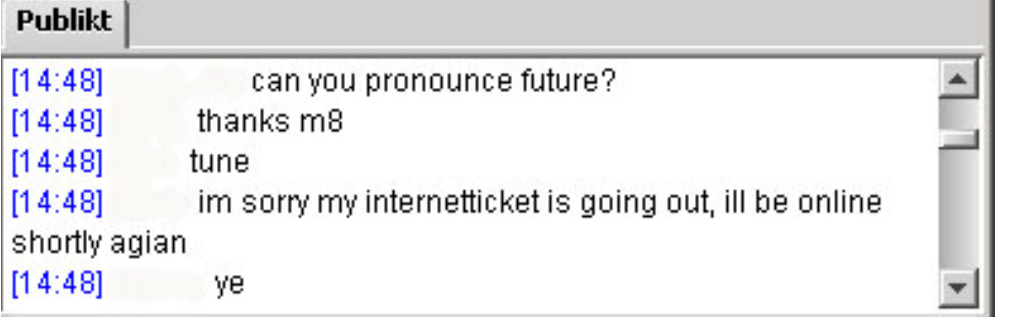
Figure 3 . Excerpt from the text chat box in a Marratech seminar. Internet time runs out (names removed from image).